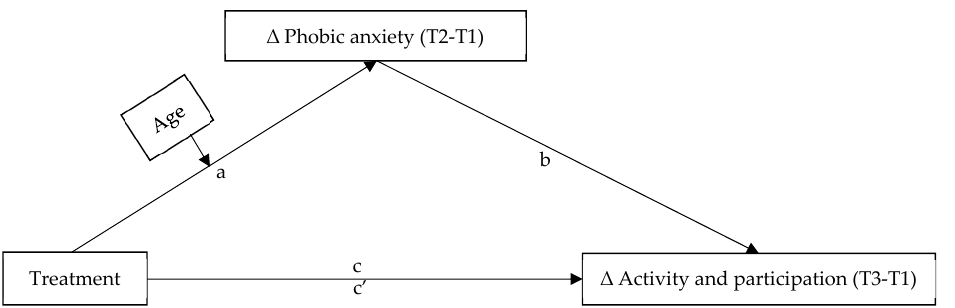
Figure 1. Conceptual model predicting mechanisms of treatment effectiveness in activity and participation mediated by phobic anxiety and moderated by age.